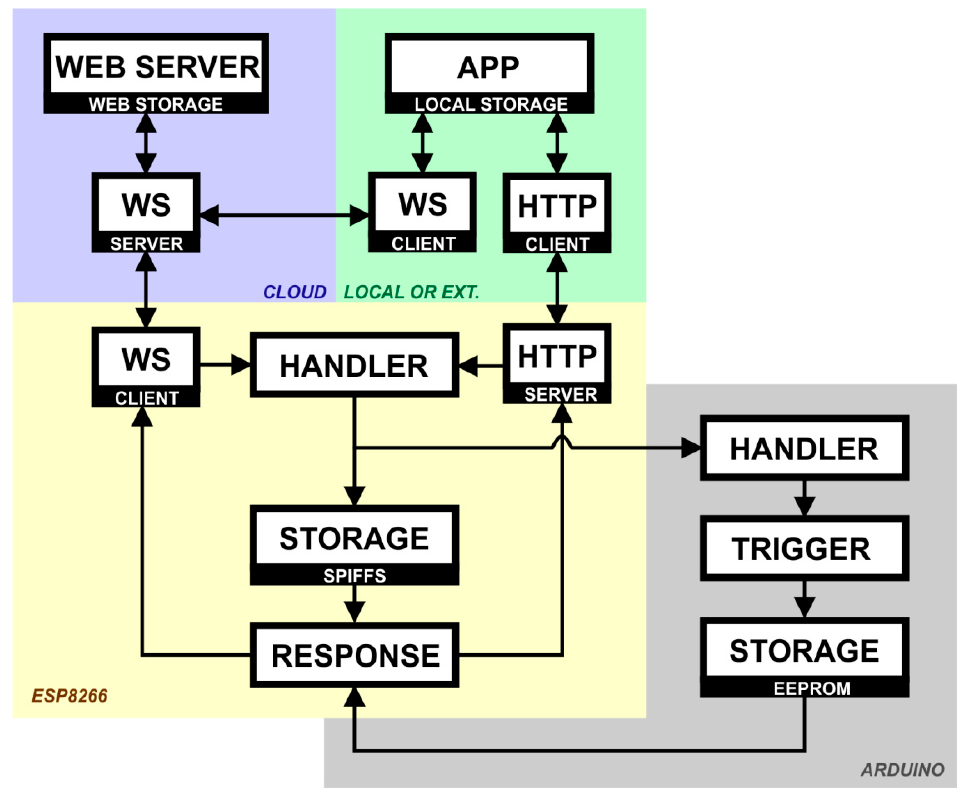
Figure 3. Connectivity of the assistive system.